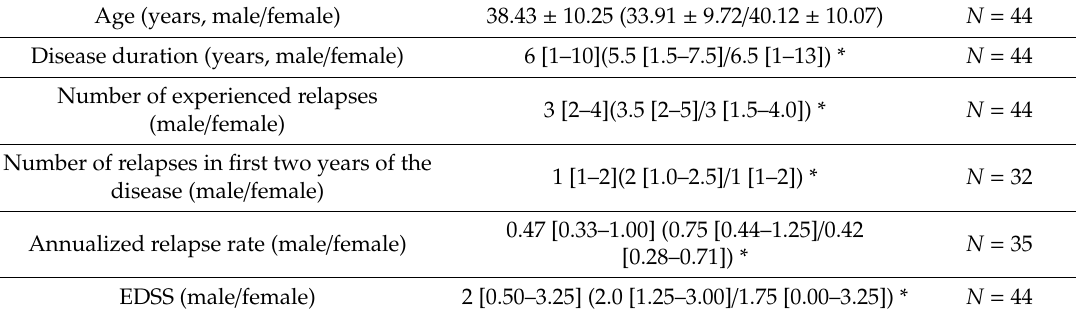
Table 1. Characteristics of the study